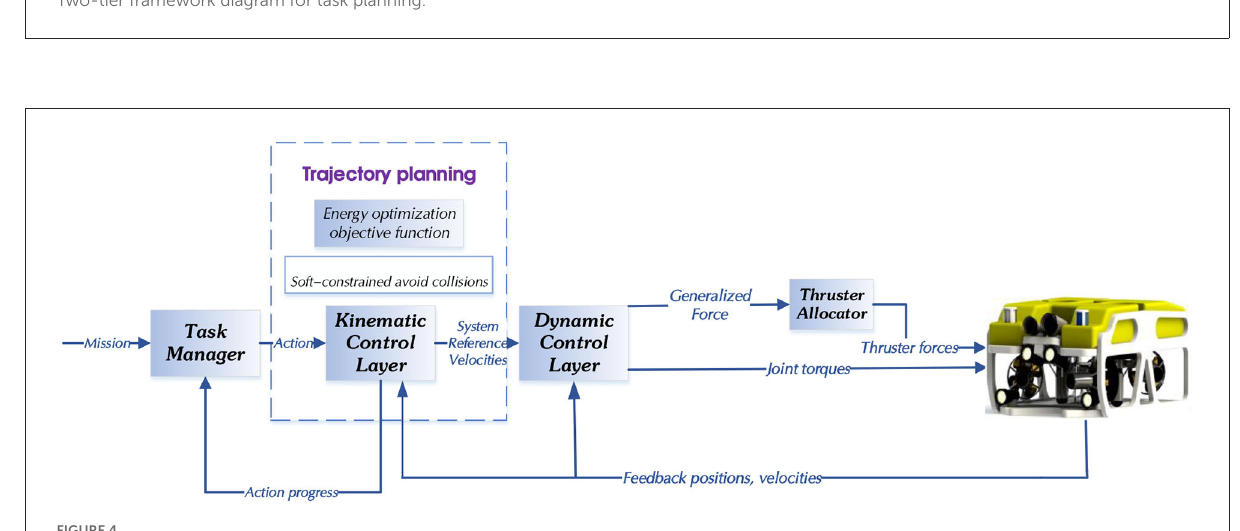
FIGURE3 Two-tier framework diagram for task planning.